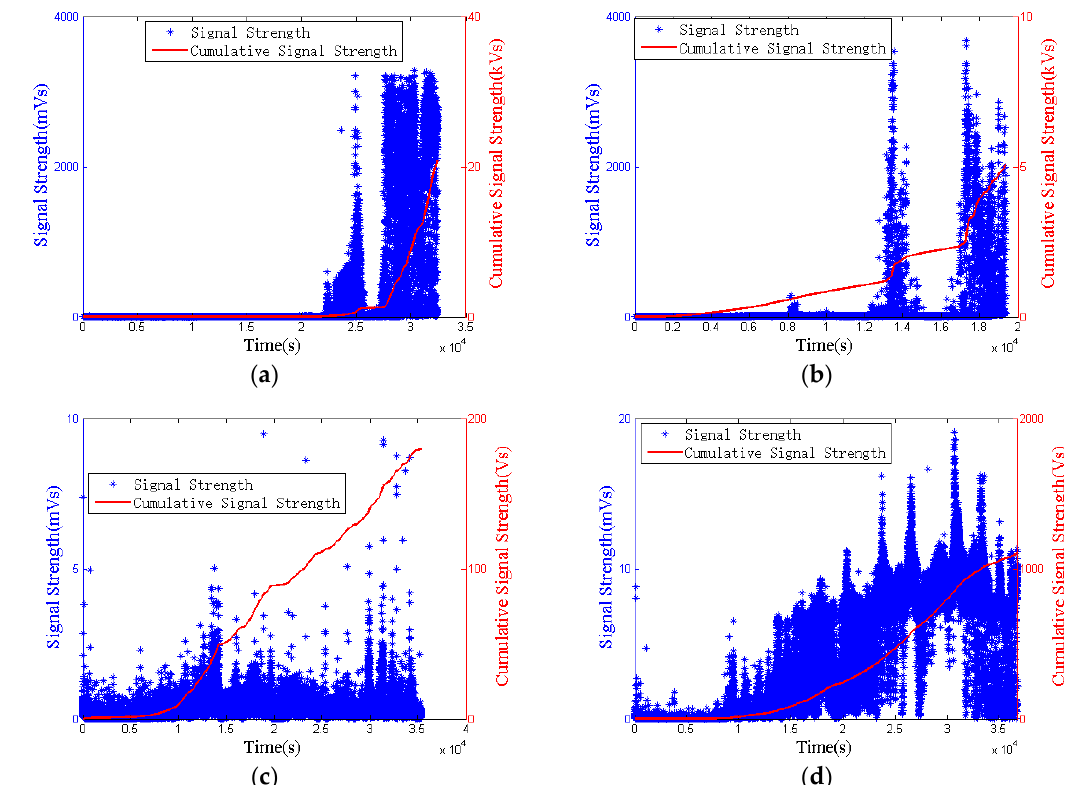
Figure 6. The signal strength and the accumulative signal strength: ( a ) The first specimen; ( b ) the second specimen; ( c ) the third specimen; ( d ) the fourth specimen.